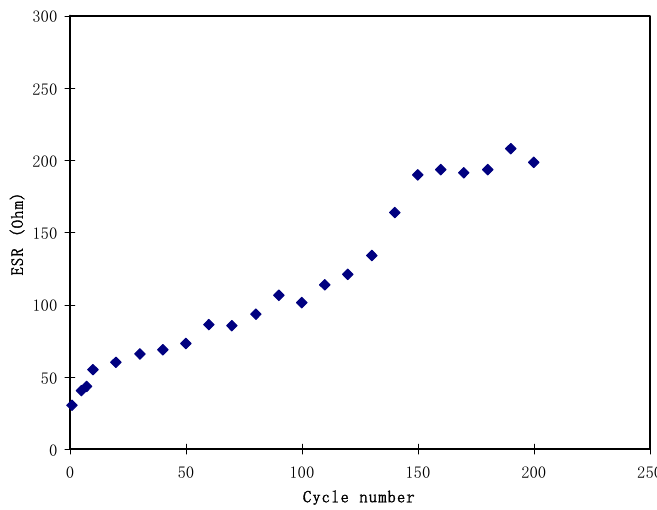
/ cm 2 for 200 complete cycles.